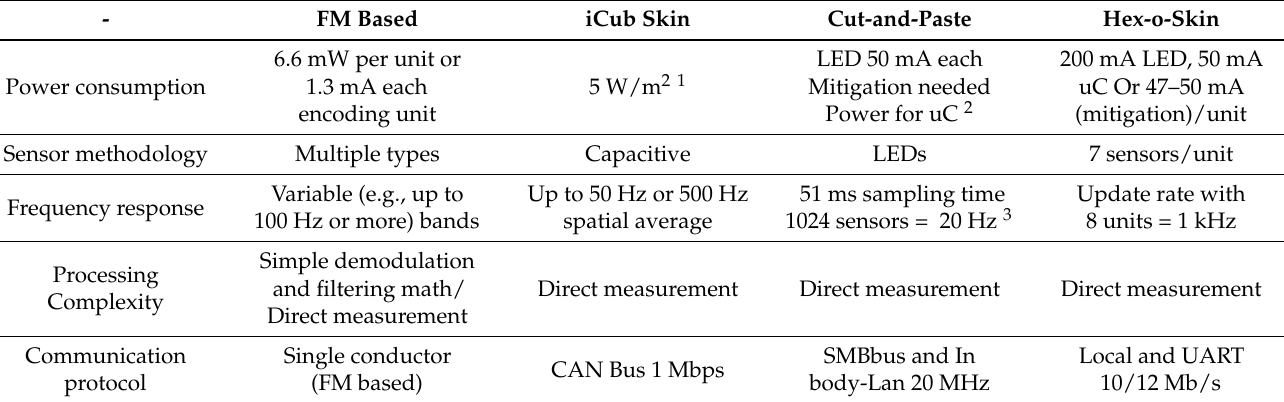
Table 1. The table briefly captures key features of the Frequency Modulation (FM) approach vs. literature systems. The values are collected from papers and reviews. NOTES: ( 1 ) mW or mA per unit (without sensor overhead) cannot be found but the power consumption per m 2 is competitive. ( 2 ) The use of microcontrollers for every 4 sensors and main bus management are assumed to have a higher power demand than the proposed solution although a specific value could not be ascertained in the published work. ( 3 ) Estimated from the time latency reported in the work.